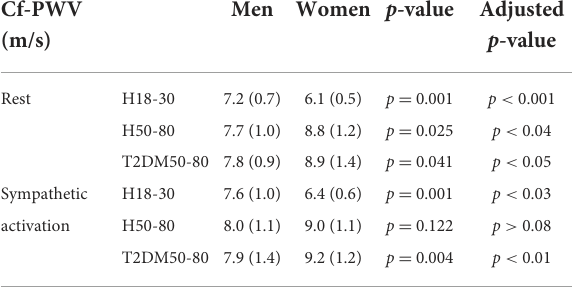
TABLE 3 Sex differences in cf-PWV at rest and during sympathetic activation within each